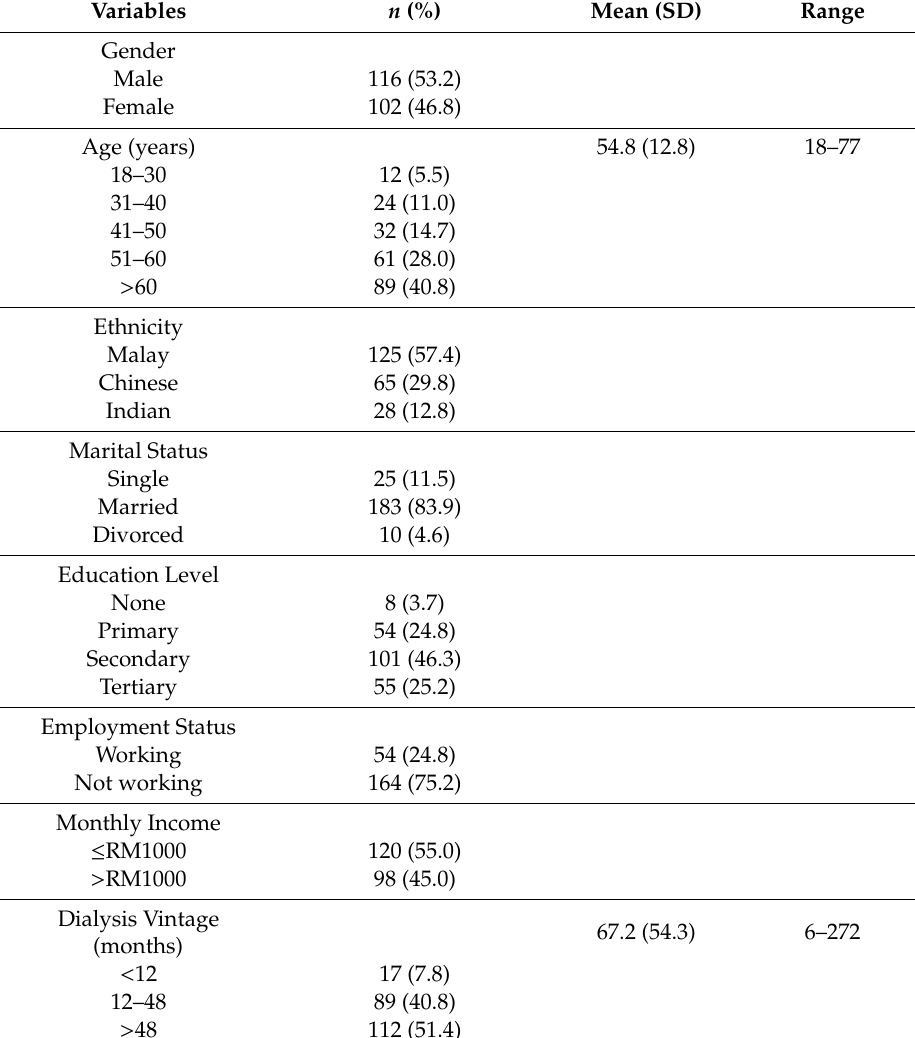
Table 1. Sociodemographic Profile of the Respondents ( n =